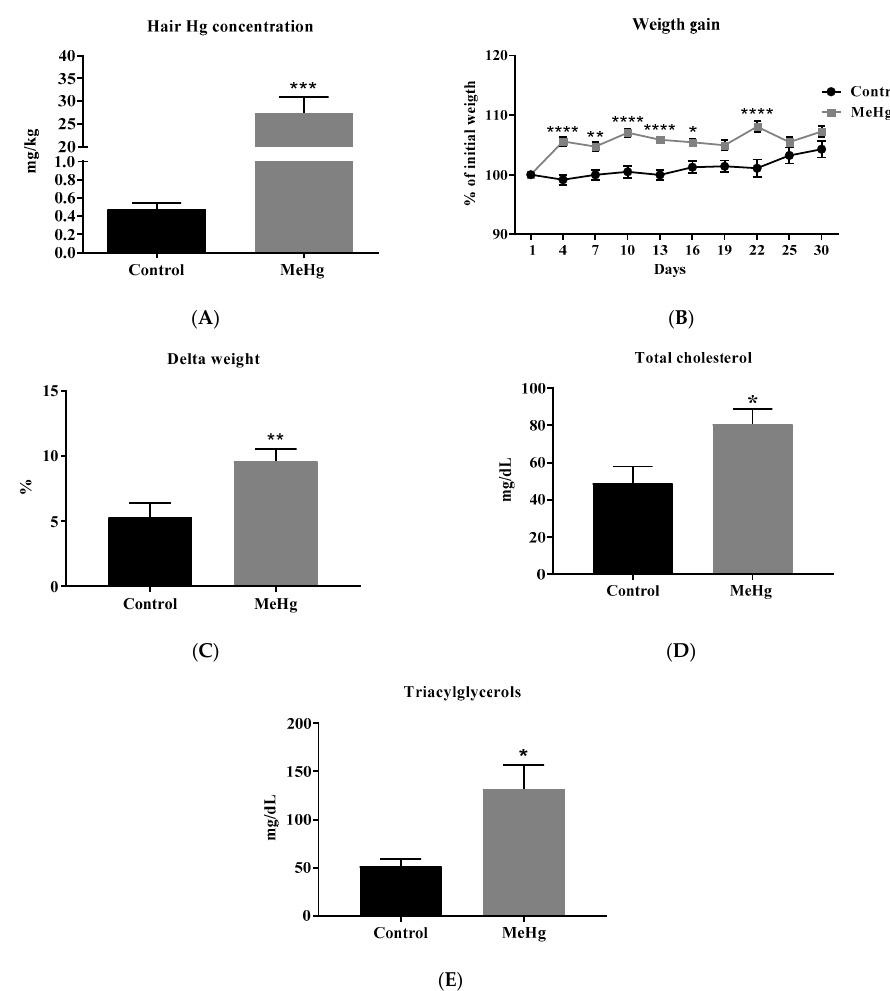
Figure 1. MeHg intoxication and metabolic changes. Values are expressed as the mean ± SEM. ( A ) Hair Hg concentration. *** p < 0.001 vs. the control ( B , C ). Effect of the oral administration of MeHg (2 mg/L) over 30 days on the body weight percentage of adult C57BL6J mice, n = 20 per group. * p < 0.05, ** p < 0.001 ****, p < 0.0001 vs. control by two-way ANOVA and Bonferroni’s test. ( D , E ) Effect of MeHg 30 days of intoxication on the cholesterol and triglyceride plasma levels, n = 6 per group. * p < 0.05 vs. control by the unpaired Student t -test.